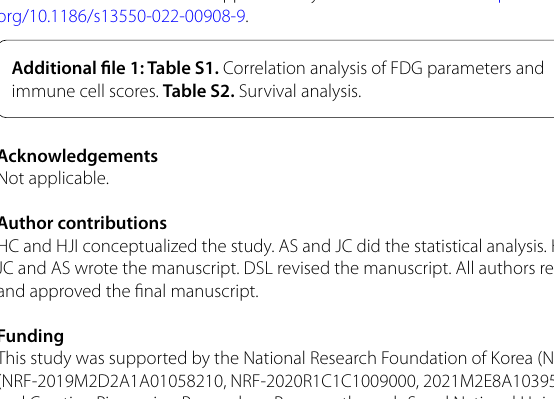
Additional file 1: Table S1. Correlation analysis of FDG parameters and immune cell scores. Table S2. Survival analysis. Acknowledgements Not